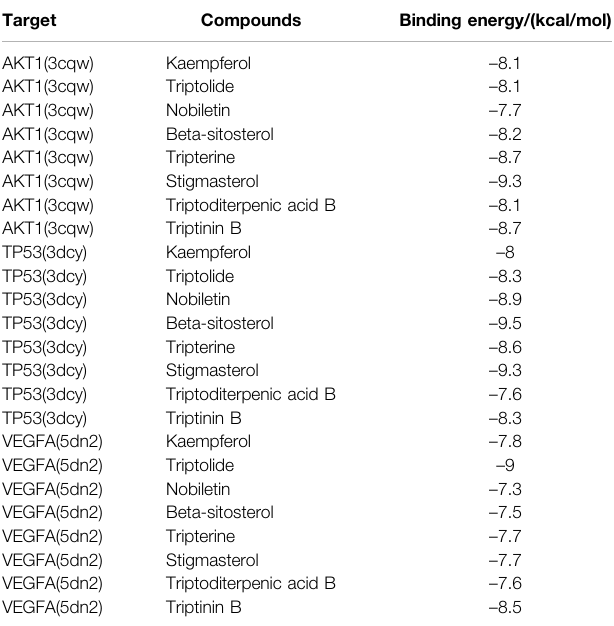
TABLE 3 | The binding energyvalues of core compounds ofTW and core